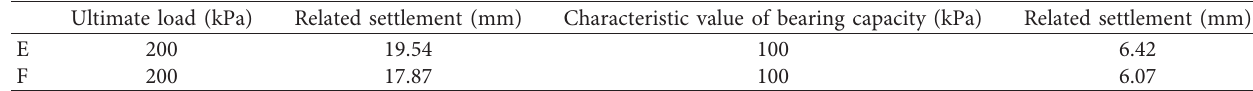
Table 8: Detection results of bearing capacity in